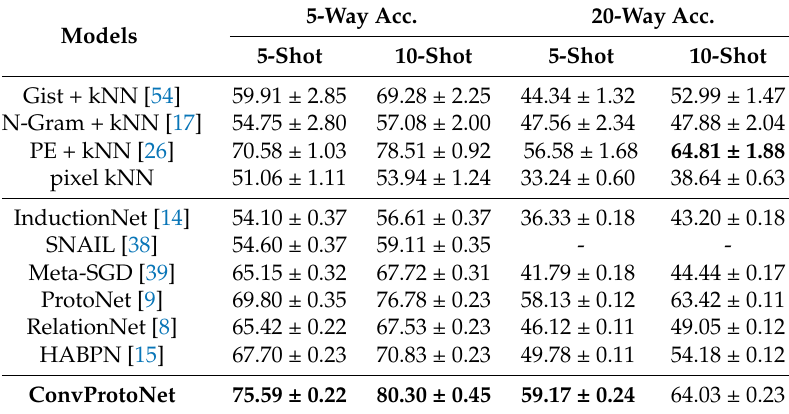
Table 2. Test accuracy and 95% confidence interval for malware few-shot classification on VirusShare dataset. Note that PE meta-data often fails to extract features for corrupted PE header of many classes. Bold items indicate the highest accuracy among all models under the same experiment setting.